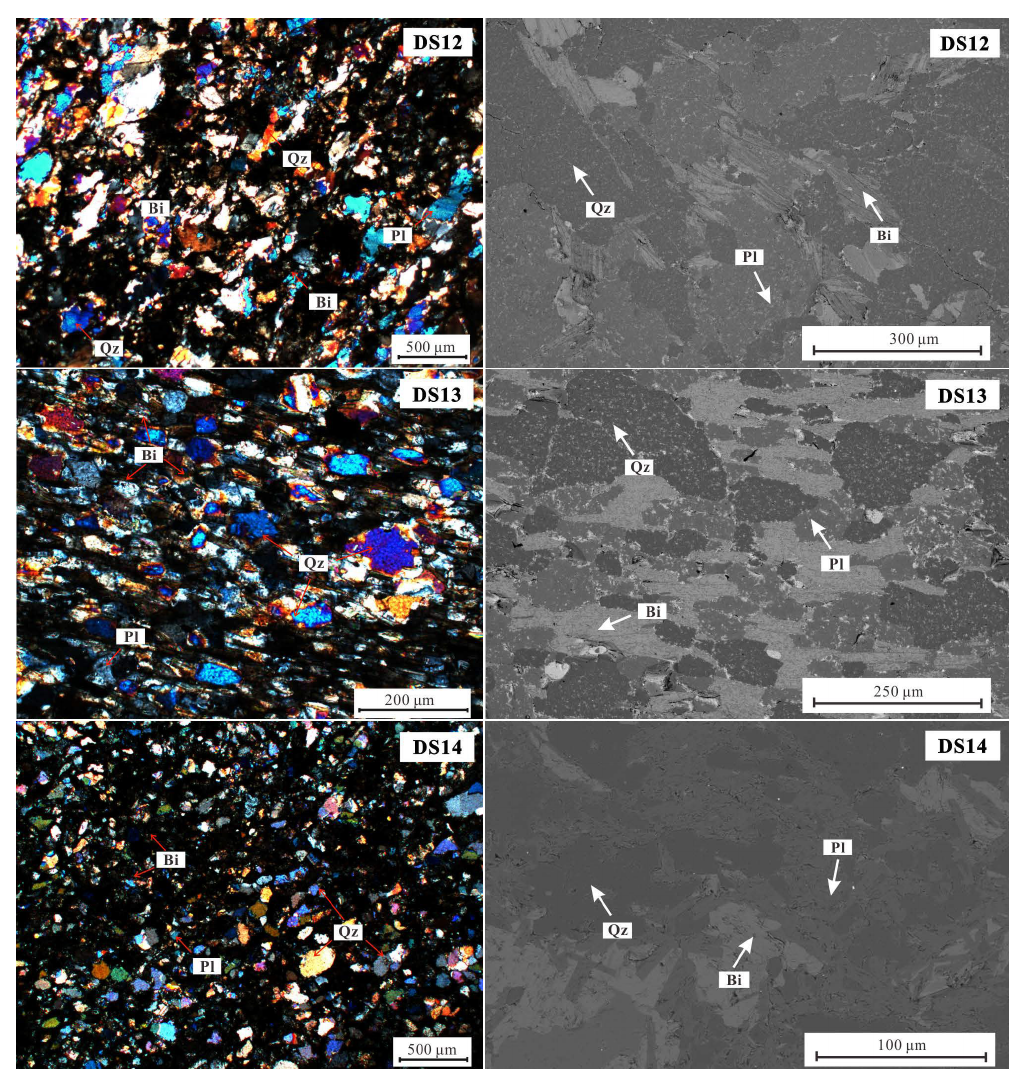
Figure 1. Photomicrographs and electron backscattered images of three natural gneiss samples under the polarizing microscope. Pl: plagio- clase, Qtz: quartz and Bt: